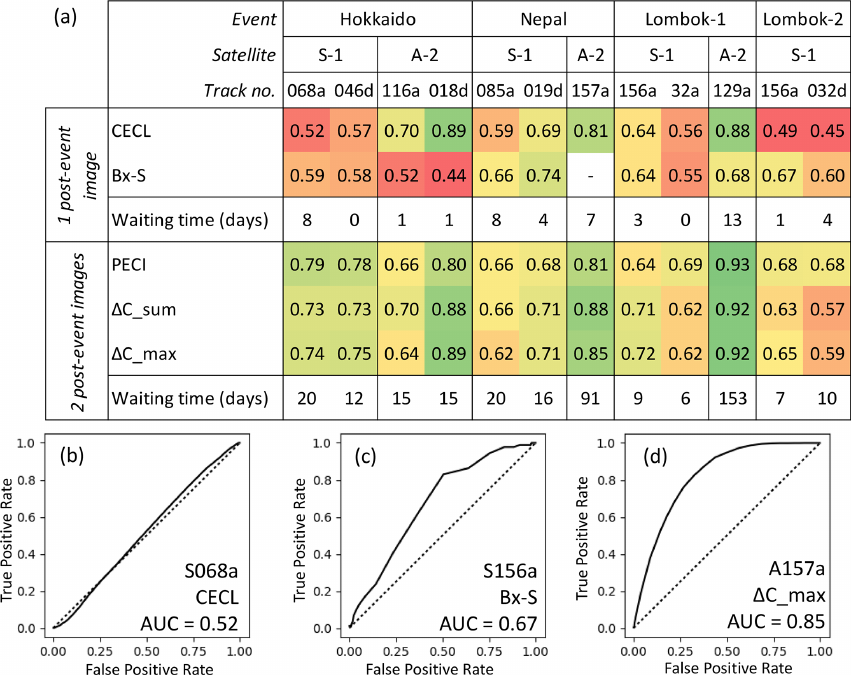
Figure 2. (a) AUC values for each classifier described in Sect. 2 at a resolution of 200m × 220m. For Hokkaido, we use the inventory of Zhang et al. (2019). Insufficient pre-event data were available on A157a to calculate the Bx–S classification surface. Colours range from red (worst-performing, AUC < 0.55) to green (best-performing, AUC > 0.80). (b–d) Examples of ROC curves for (b) the CECL method on track S156a, Hokkaido; (c) the Bx–S method on track S156a, Lombok-2; (d) (cid:49) C_max on track A157a,